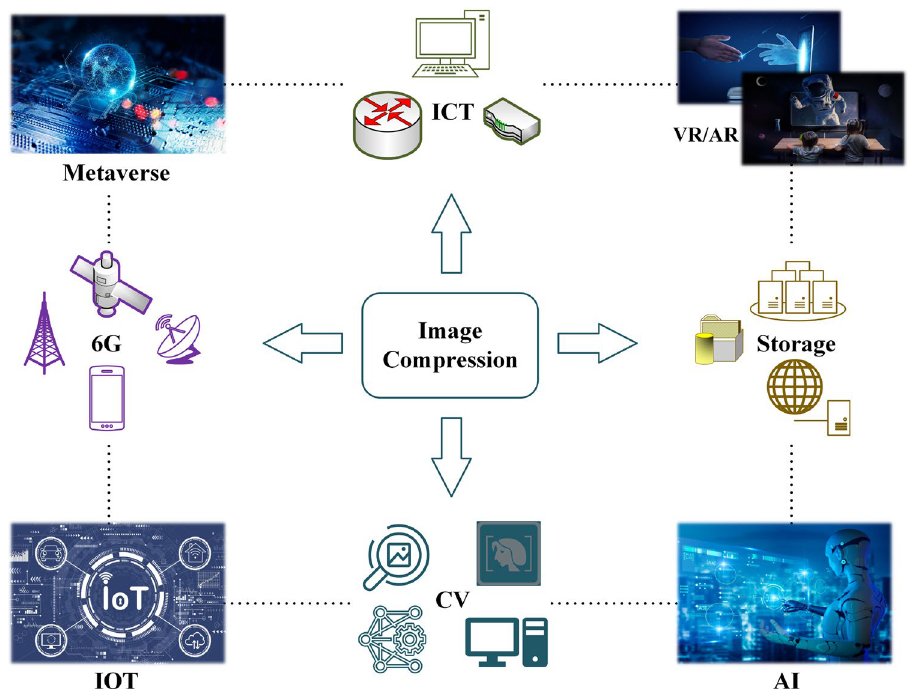
Figure 1. Image compression plays an important role in several scenarios, such as virtual reality (VR), augmented reality (AR), computer vision (CV), and the Internet of Things